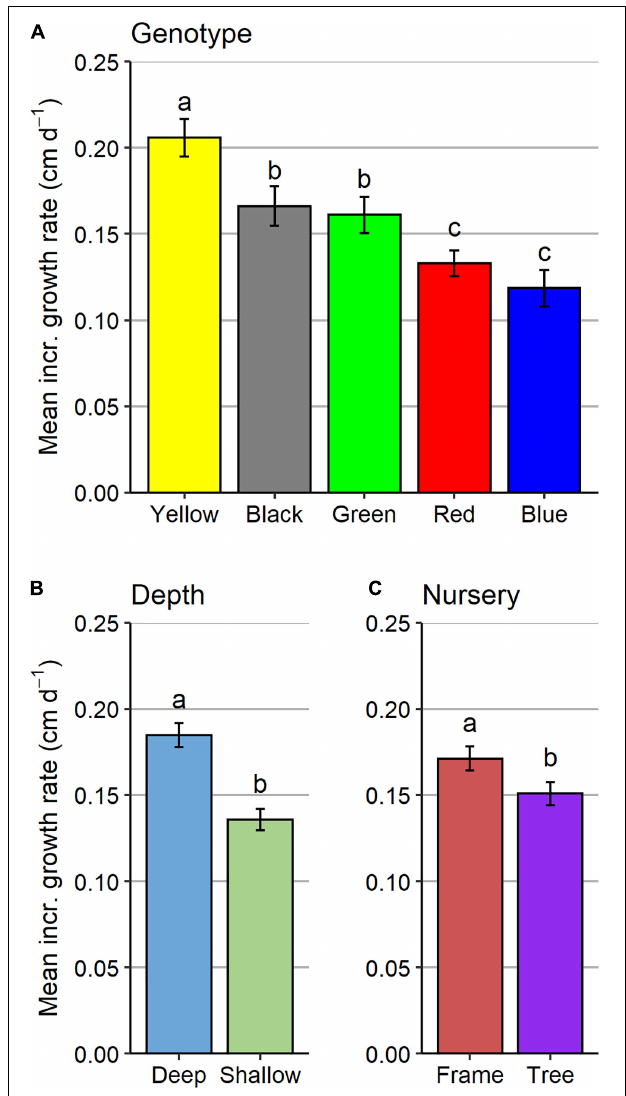
FIGURE 3 | Mean incremental growth rates ± standard errors (SE) for (A) different genotypes, (B) depths, and (C) nurseries. Incr.,